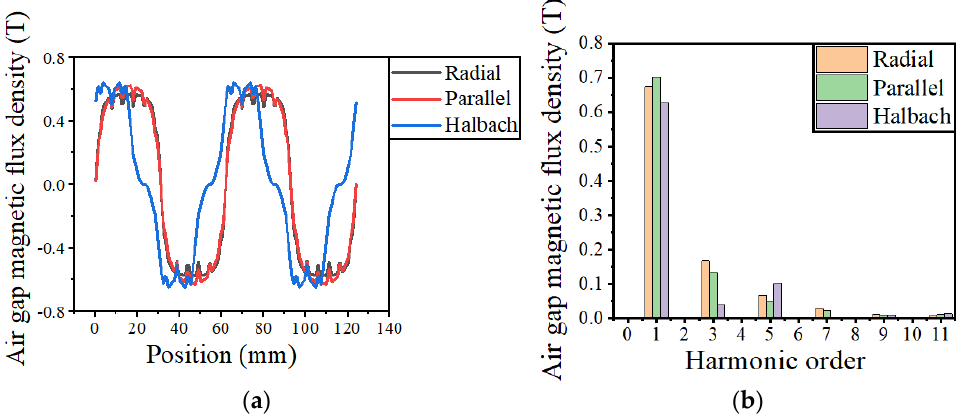
Figure 10. Waveforms and FFT analysis results of air gap magnetic flux density for HSPMMs with different magnetization methods. ( a ) Waveforms; ( b ) FFT analysis results.